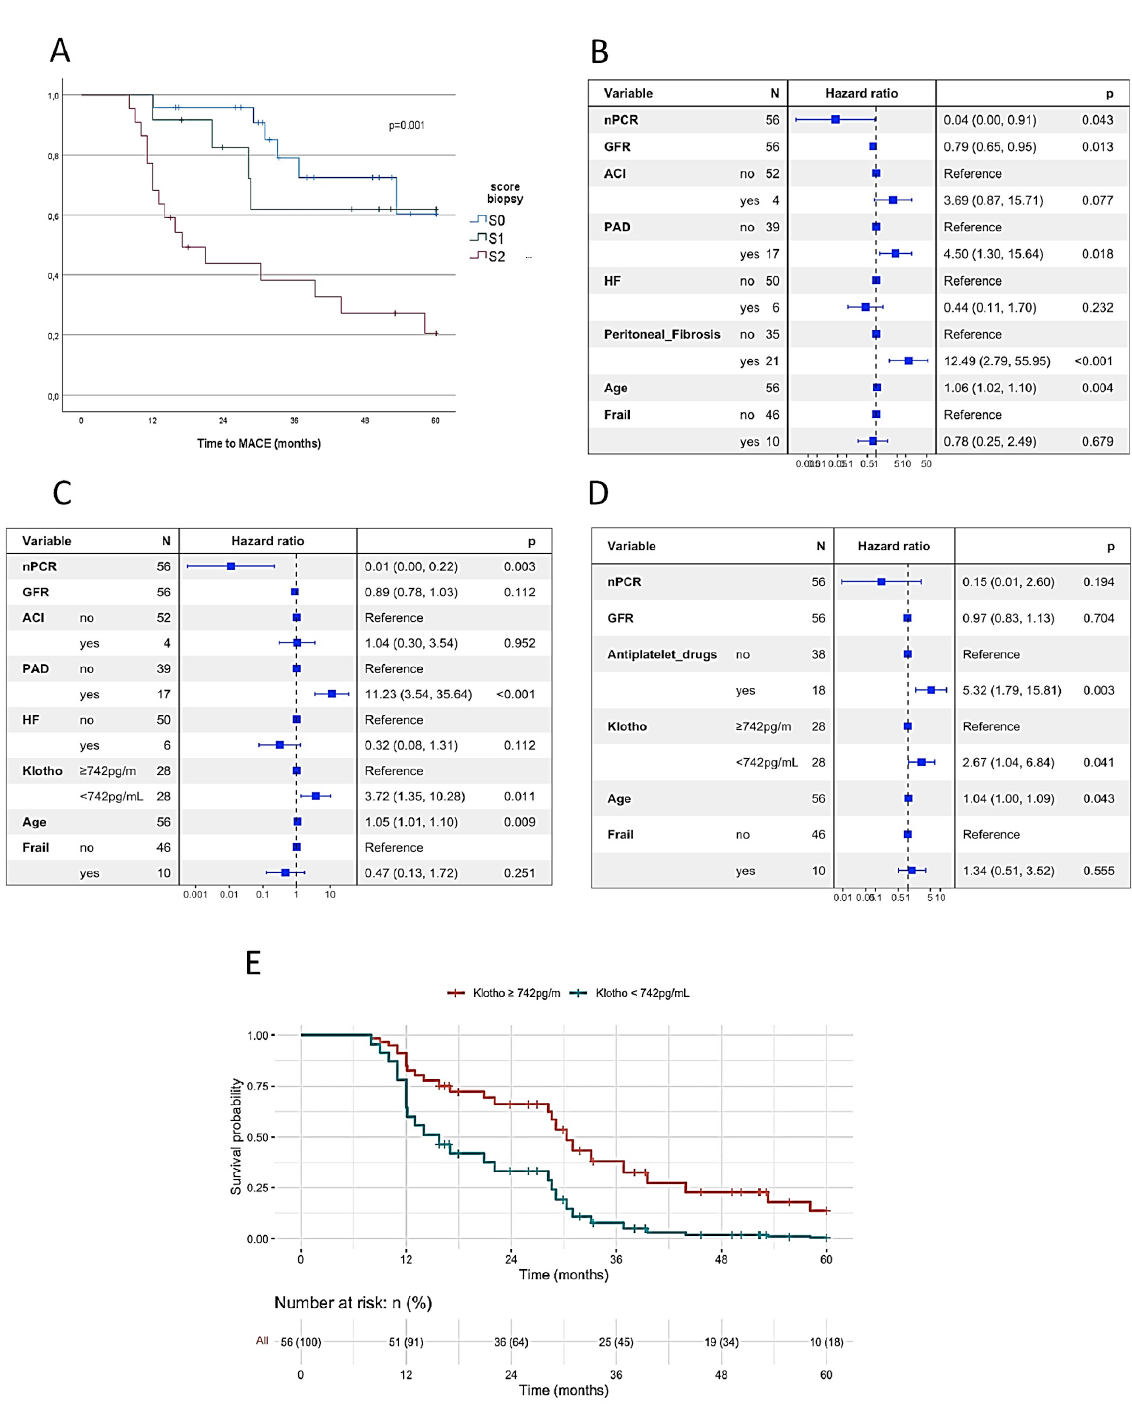
Figure 2. Predictors of time to major cardiovascular event (MACE). ( A ) Survival curve for time until MACE accordingly to peritoneal membrane status. ( B ) Multivariate Cox model that includes peritoneal fibrosis as an indicator of the membrane status adjusted for age, nutritional status, frailty and PAD. ( C ) Multivariate Cox model similar to B, but using α -Klotho cutoff as a surrogate of membrane fibrosis. ( D ) Multivariate Cox model using levels of circulating α -Klotho as surrogate of membrane fibrosis and using the antiplatelet therapy as an indicator of atherosclerotic arterial disease. ( E ) Survival curves for time until MACE according to α -Klotho cutoff of 742 pg/mL. GFR—glomerular filtration; PAD—peripheral arterial disease; CHD—coronary heart disease; HF—heart failure; nPCR—normalized protein catabolic